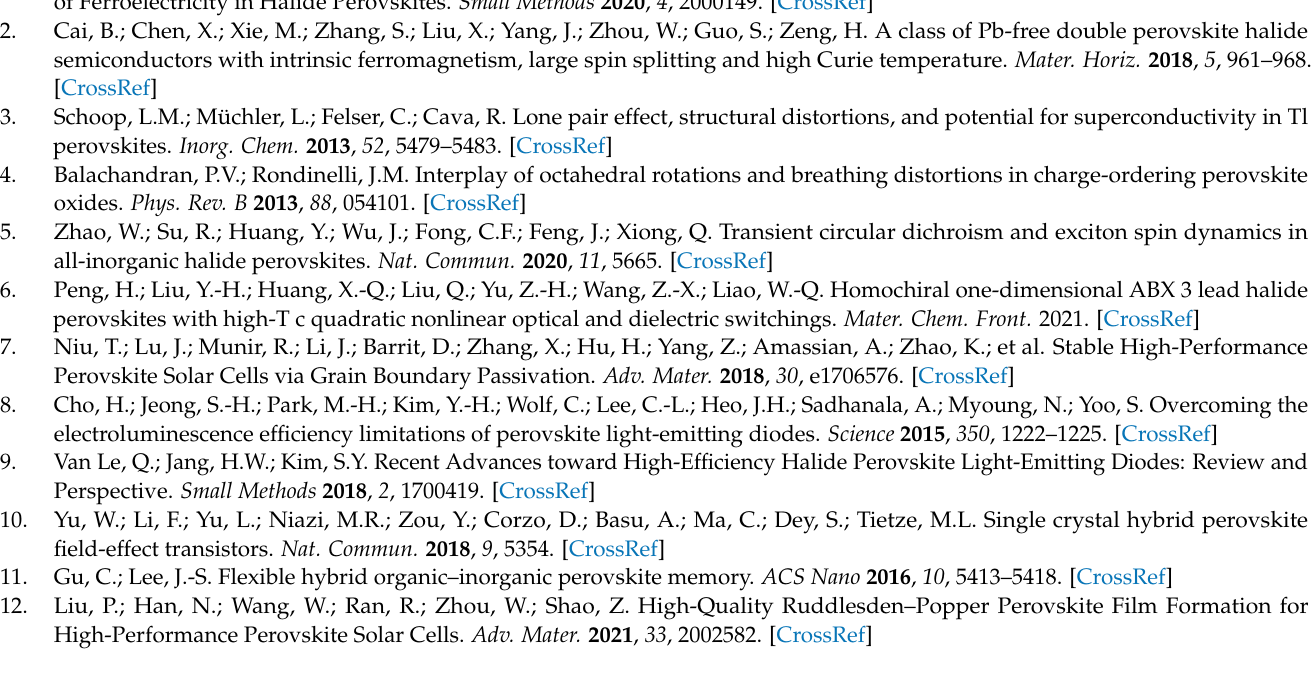
Figure S2: XPS photoelectron spectra for three different CTO films at each element; Figure S3: I–V curve samples at NCs: 1; Figure S4: I–V curve samples at NCs: 2; Figure S5: I–V curve samples at NCs: